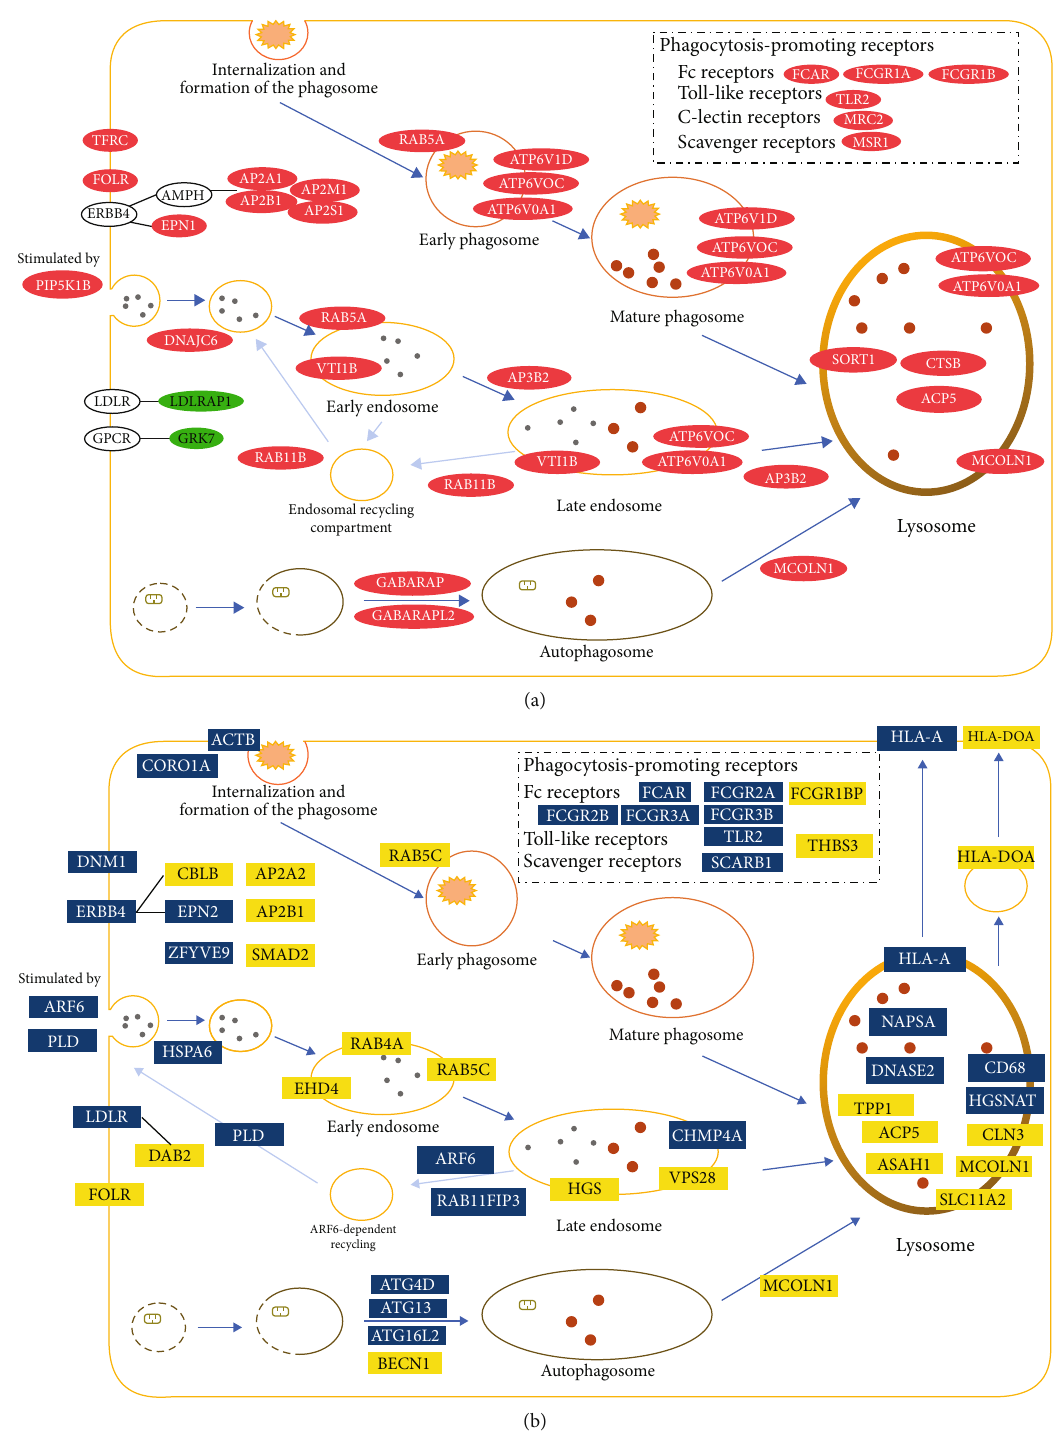
Figure 6: Overview of phagosome/endosome/autophagy-lysosome pathways in PBMCs from patients with decompensated cirrhosis. (a) The overview of phagosome/endosome/autophagy-lysosome pathways based on the expression levels of di ff erentially expressed mRNAs. The fi gure was drawn according to the information from KEGG PATHWAY database. The molecules in red were upregulated in PBMCs from DCC patients, and the molecules in green were downregulated in PBMCs from DCC patients. (b) The overview of phagosome/ endosome/autophagy-lysosome pathways according to the target genes of DE-lncRNAs and genes involved in RASEs. The molecules in blue were lncRNA target genes, and the molecules in yellow were genes involved in